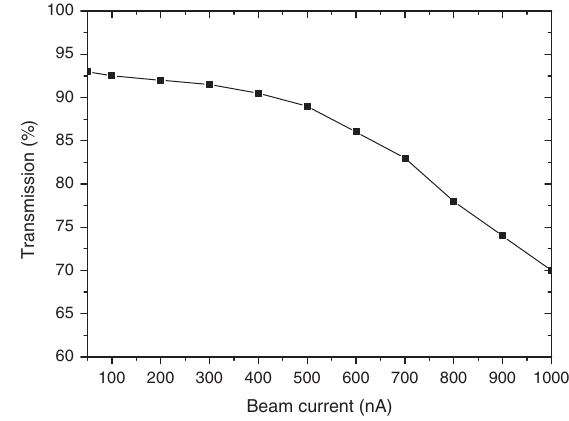
FIG. 7. Space charge effect on the ion transmission: variation of the transmission versus beam current for 2.5 Pa buffer gas